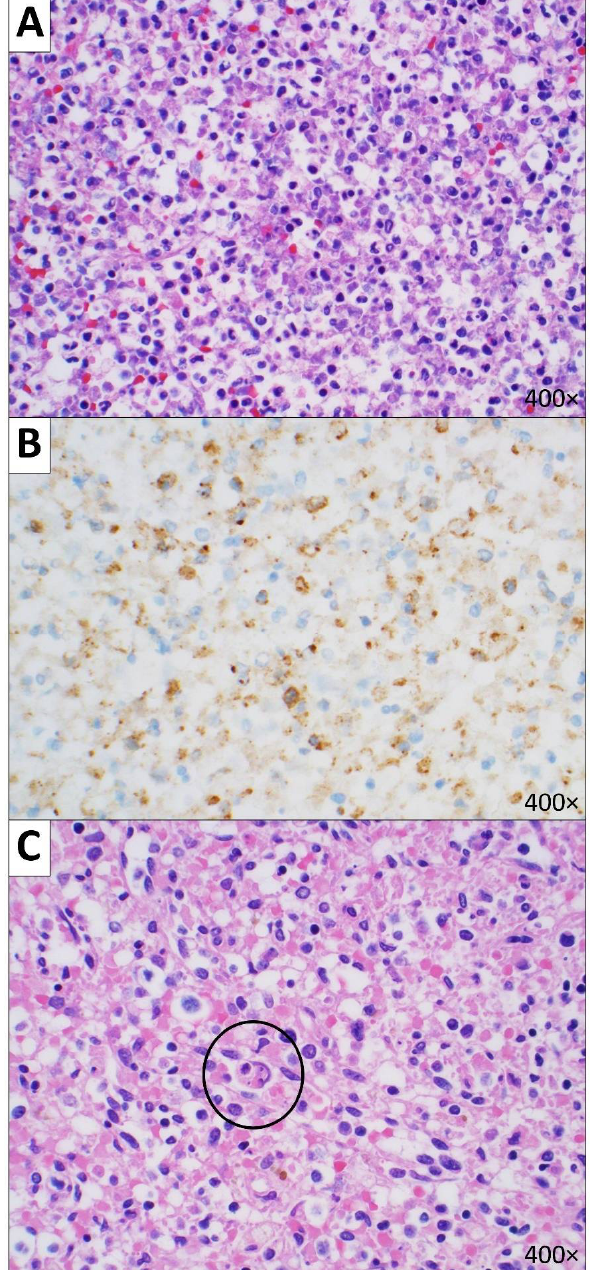
Figure 5. Microscopic images of the spleen. ( A ) AML infiltrates (H&E, 400× magnification). ( B ) AML cells were positive for myeloperoxidase (MPO) stain (400× magnification). ( C ) Hemophagocytosis cell with a macrophage engulfing an RBC are referred to with black circle (H&E, 400× magnifica- tion).